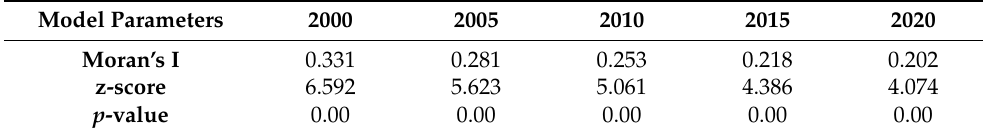
Table 5. Global Moran’s I of the coupling coordination of the WLF nexus system. Model